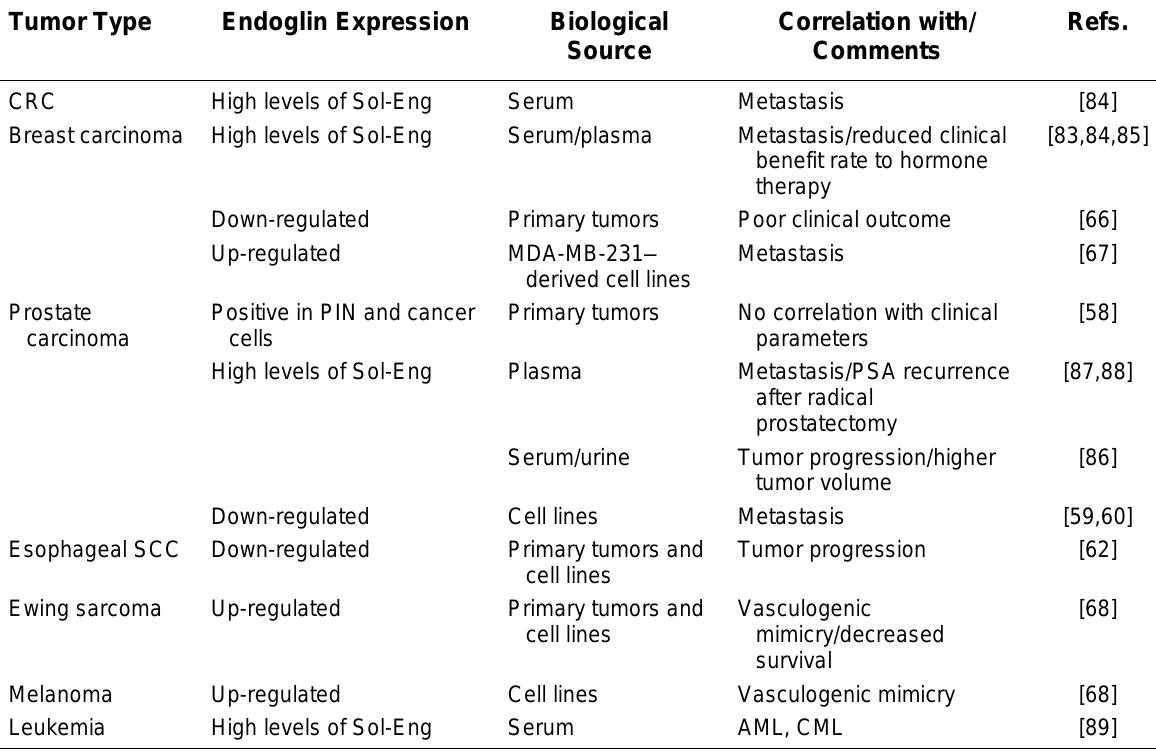
AML, acute myeloid leukemia; CML, chronic myeloid leukemia; CRC, colorectal cancer; Sol-Eng, soluble endoglin; PIN, prostatic intraepithelial